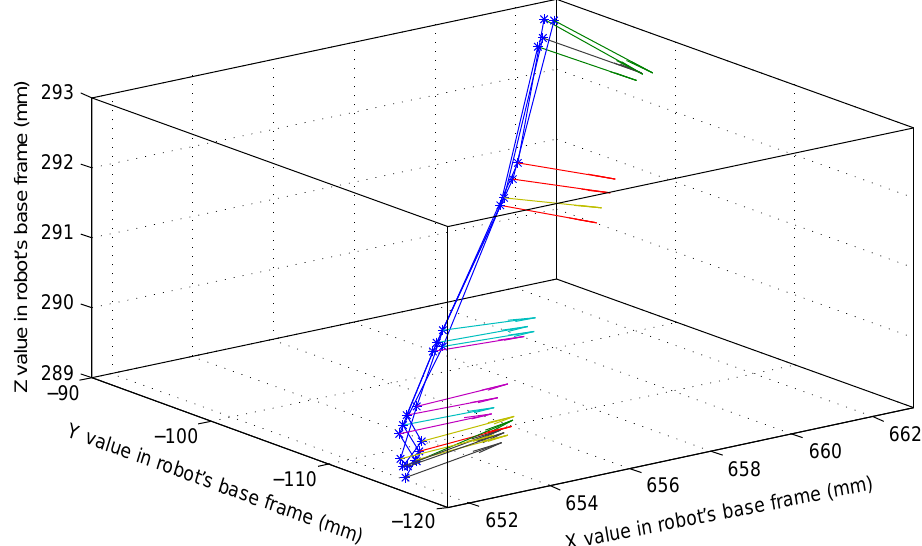
Figure 9. Machining paths obtained by the grinding robot 3D vision system with different